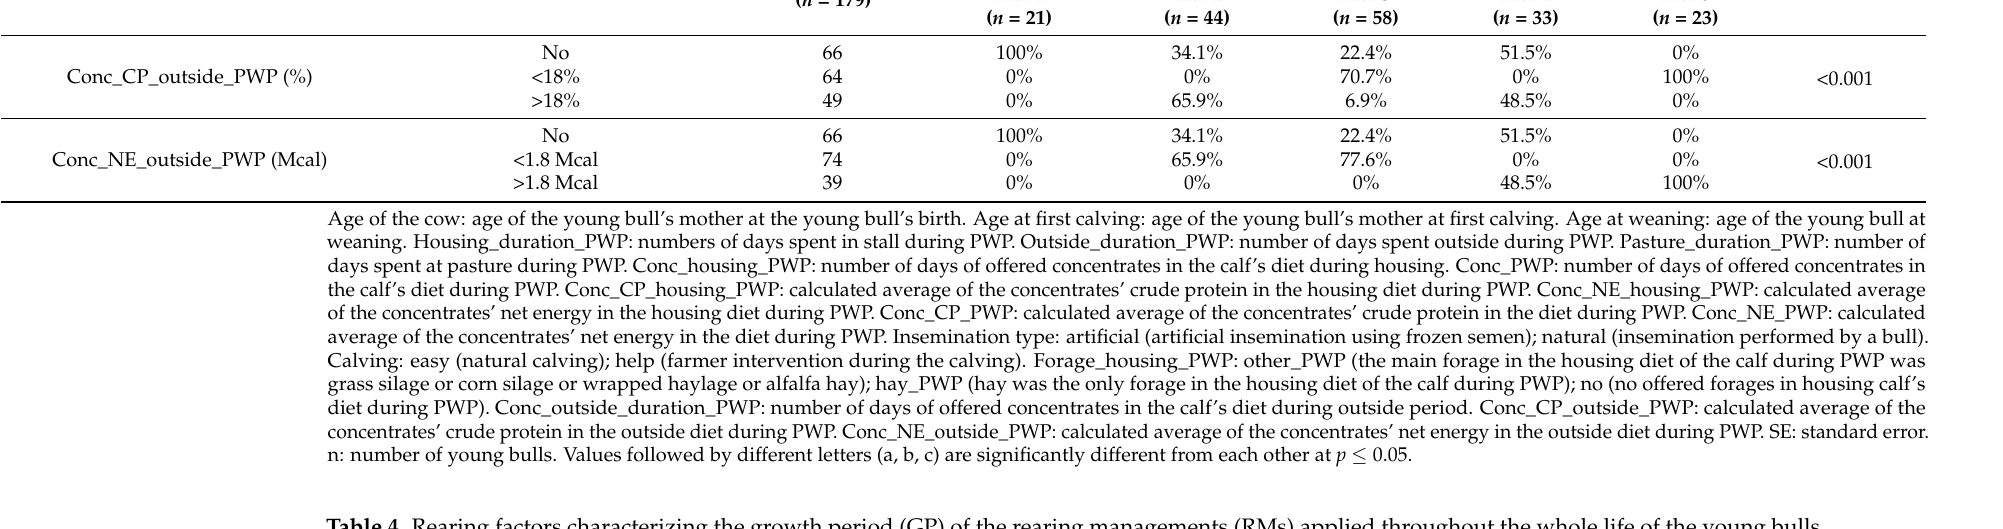
Table 4. Rearing factors characterizing the growth period (GP) of the rearing managements (RMs) applied throughout the whole life of the young bulls